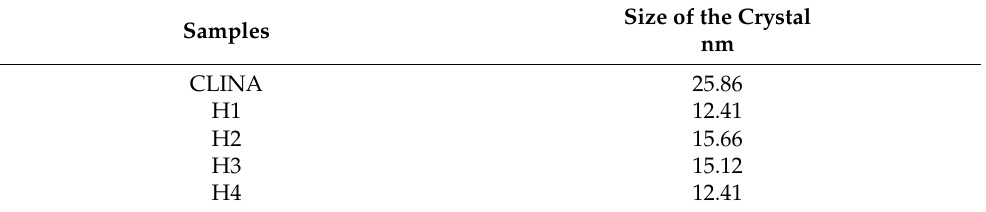
Table 2. Effect of chemical treatment with the size of crystal, XRD.